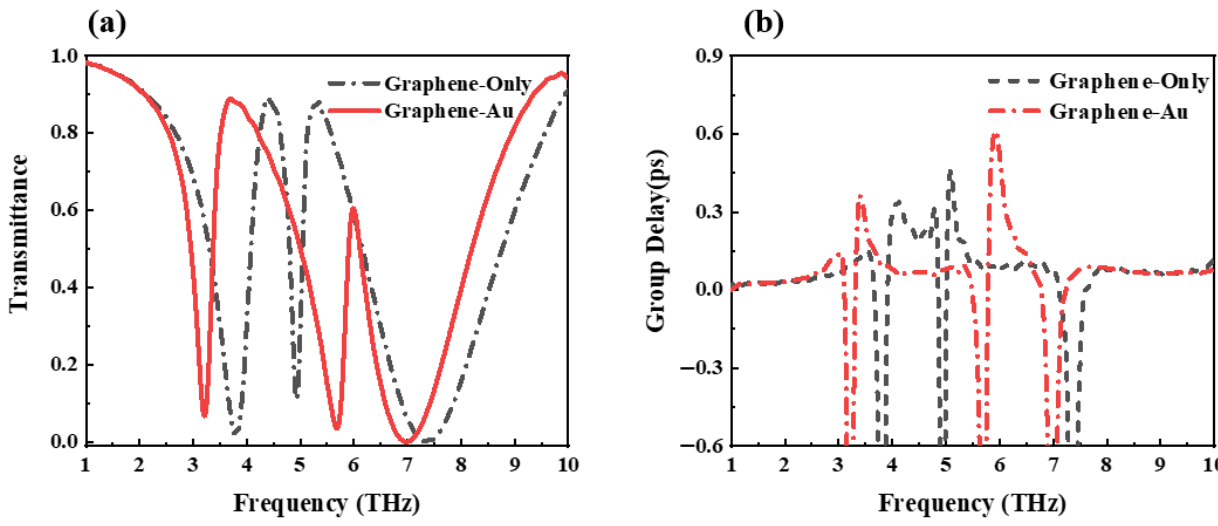
Figure 10. Comparison of ( a ) transmission spectrum and ( b ) group delay spectrum obtained by graphene-only structure and graphene–gold structure.